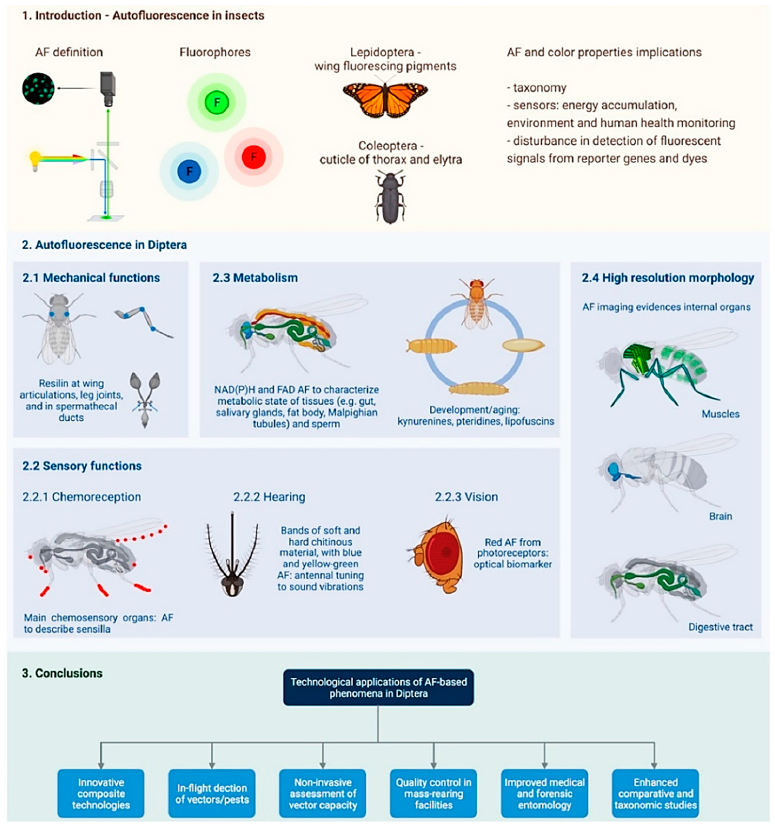
Figure 3. Schematic summary of the contents of this review. AF, autofluorescence. Created with BioRender.com (Accessed on 10 June